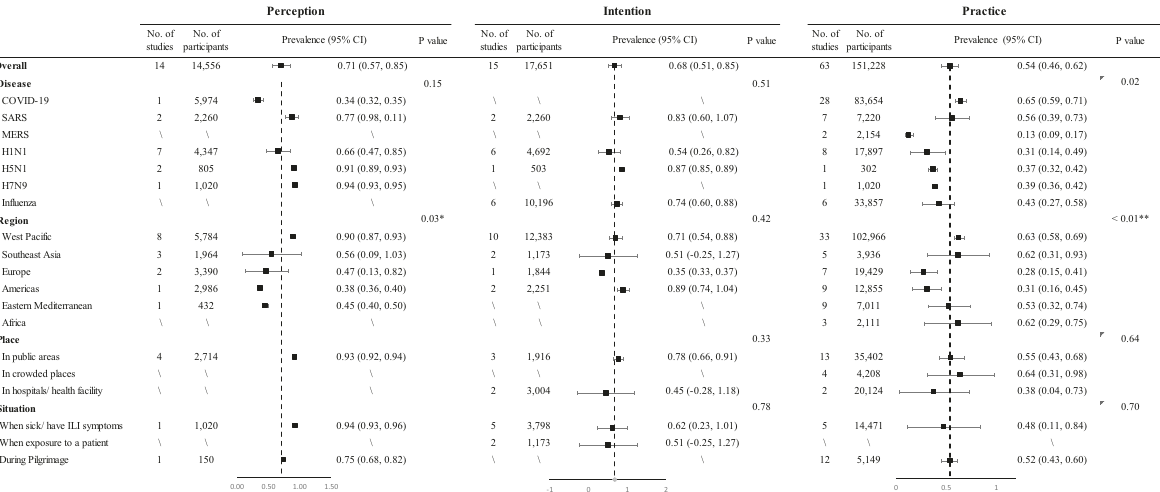
Fig. 3 Perception, intention, and practice towards facemask use in subgroups. We performed subgroup analyses of the perception, intention, and practice of facemask use, including different diseases, regions, places, and situations.